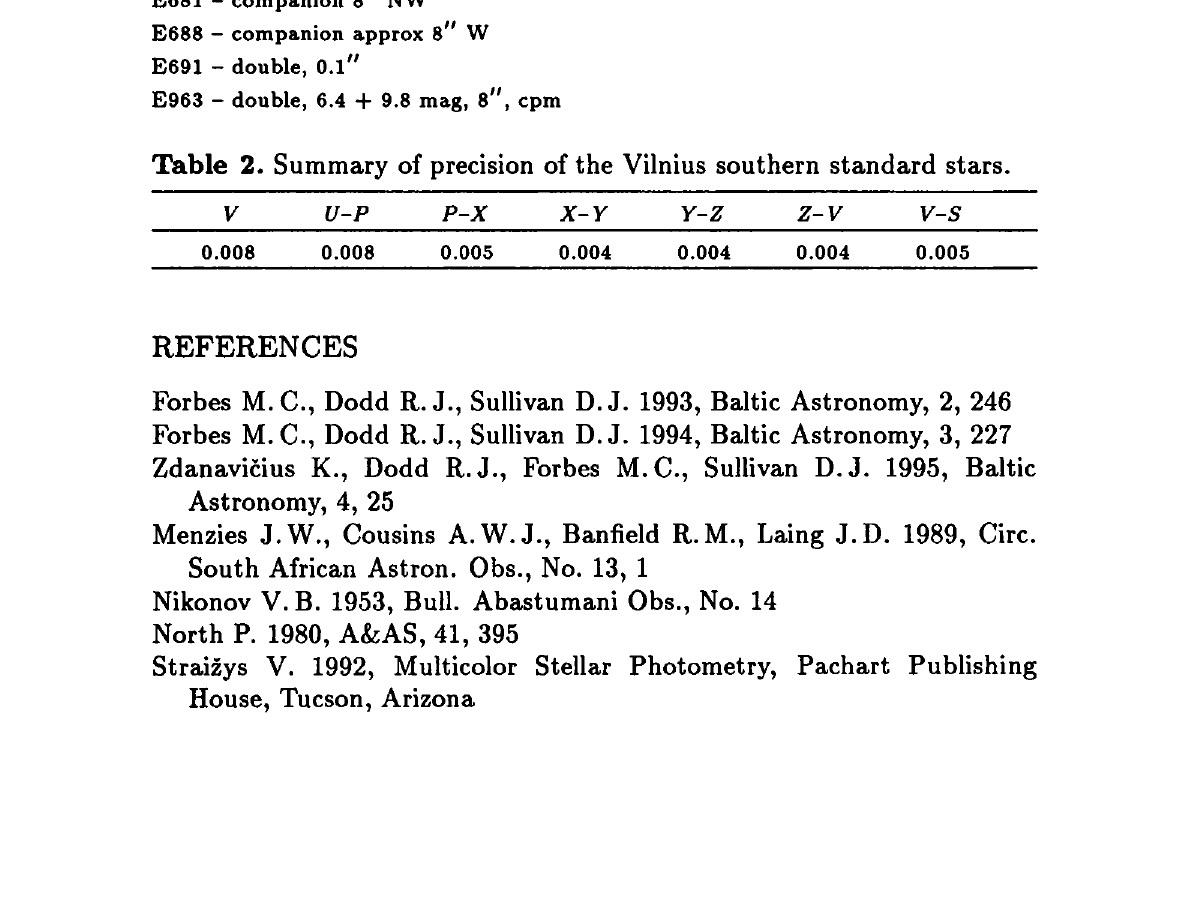
Table 2. Summary of precision of the Vilnius southern standard